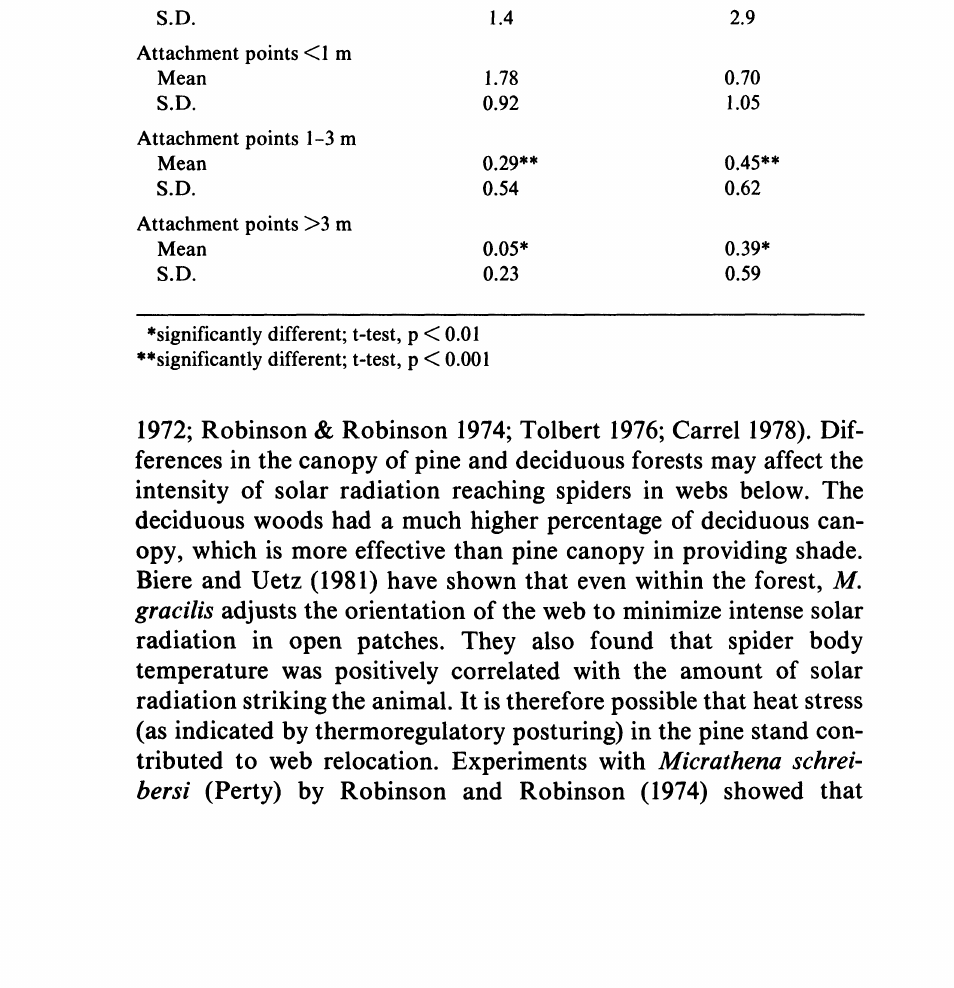
Table 3. Mean and standard-deviation (S.D.) of environmental parameters measured in each habitat. Parameter Pine Stand Deciduous Stand Relative humidity